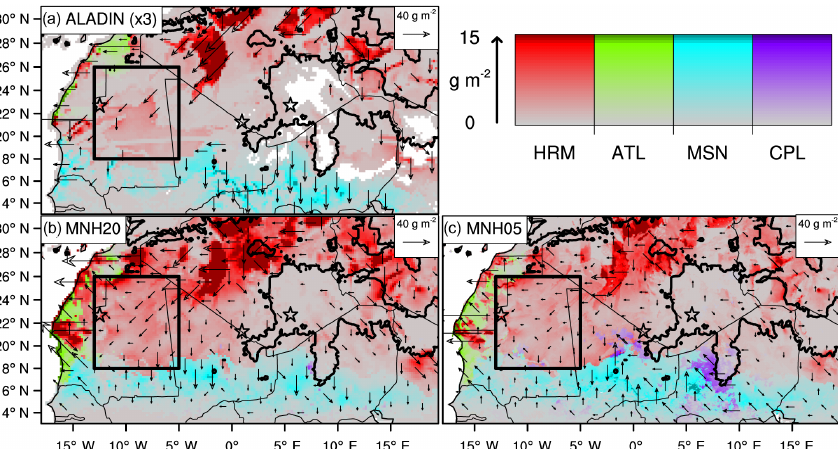
Figure 6. Three-hourly dust emission in June 2011 from (a) ALADIN, (b) MNH20 and (c) MNH05. The dust emission in ALADIN was multiplied by a factor of 3. The colours represent the dominant wind regime in emission and the colour intensity the magnitude of the dust emission. HRM, ATL, MSN and CPL stand for harmattan, Atlantic flow, monsoon flow, and cold pool, respectively. Arrows indicate the amplitude and phase of the diurnal variation of dust emission. The length of an arrow represents the magnitude of the maximum 3-hourly dust emission and its direction the time of the day when this maximum occurred with respect to a 24h clock. Arrows pointing upward indicate a peak at 00:00UTC, those toward the right indicate a peak at 06:00UTC, etc. Arrows representing less than 2gm − 2 have been omitted. The solid line shows the 600m altitude. The locations of the three AERONET stations used in this study are shown with